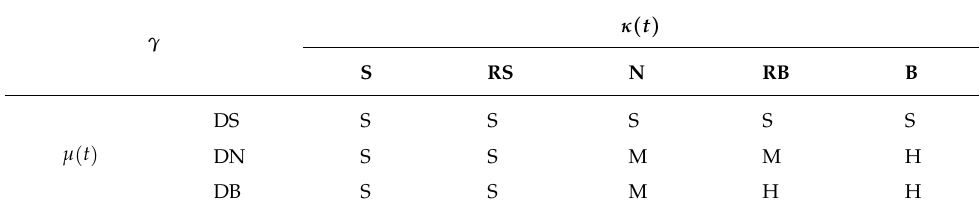
Table 2. Fuzzy rules for the weighting coefficients γ of the speed term of the